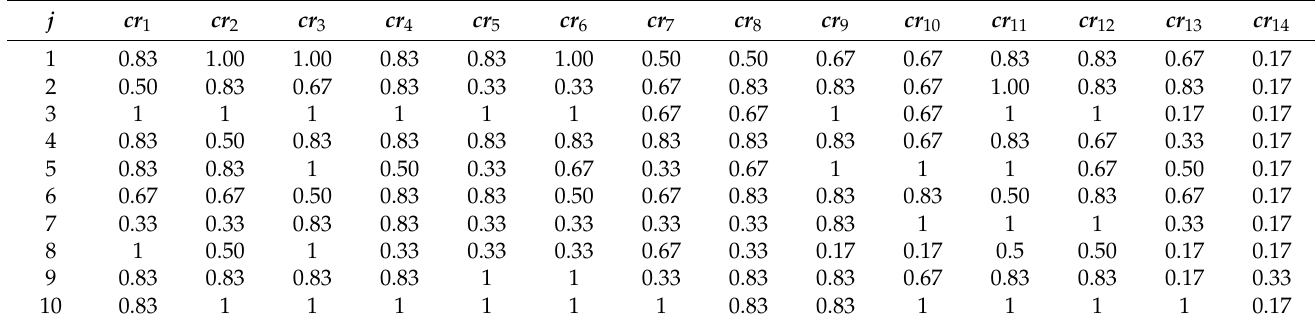
Table 5. Recalculation of the customer assessment values into o ( cr i ; j ) / L values.